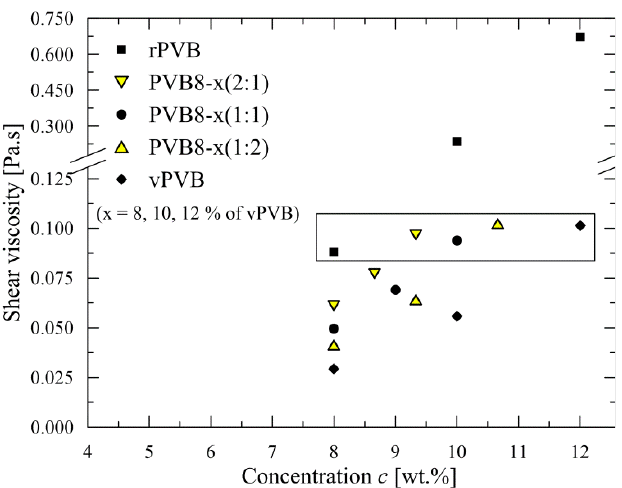
Figure 4. Dependence of shear viscosity on participation of impurities in rPVB.